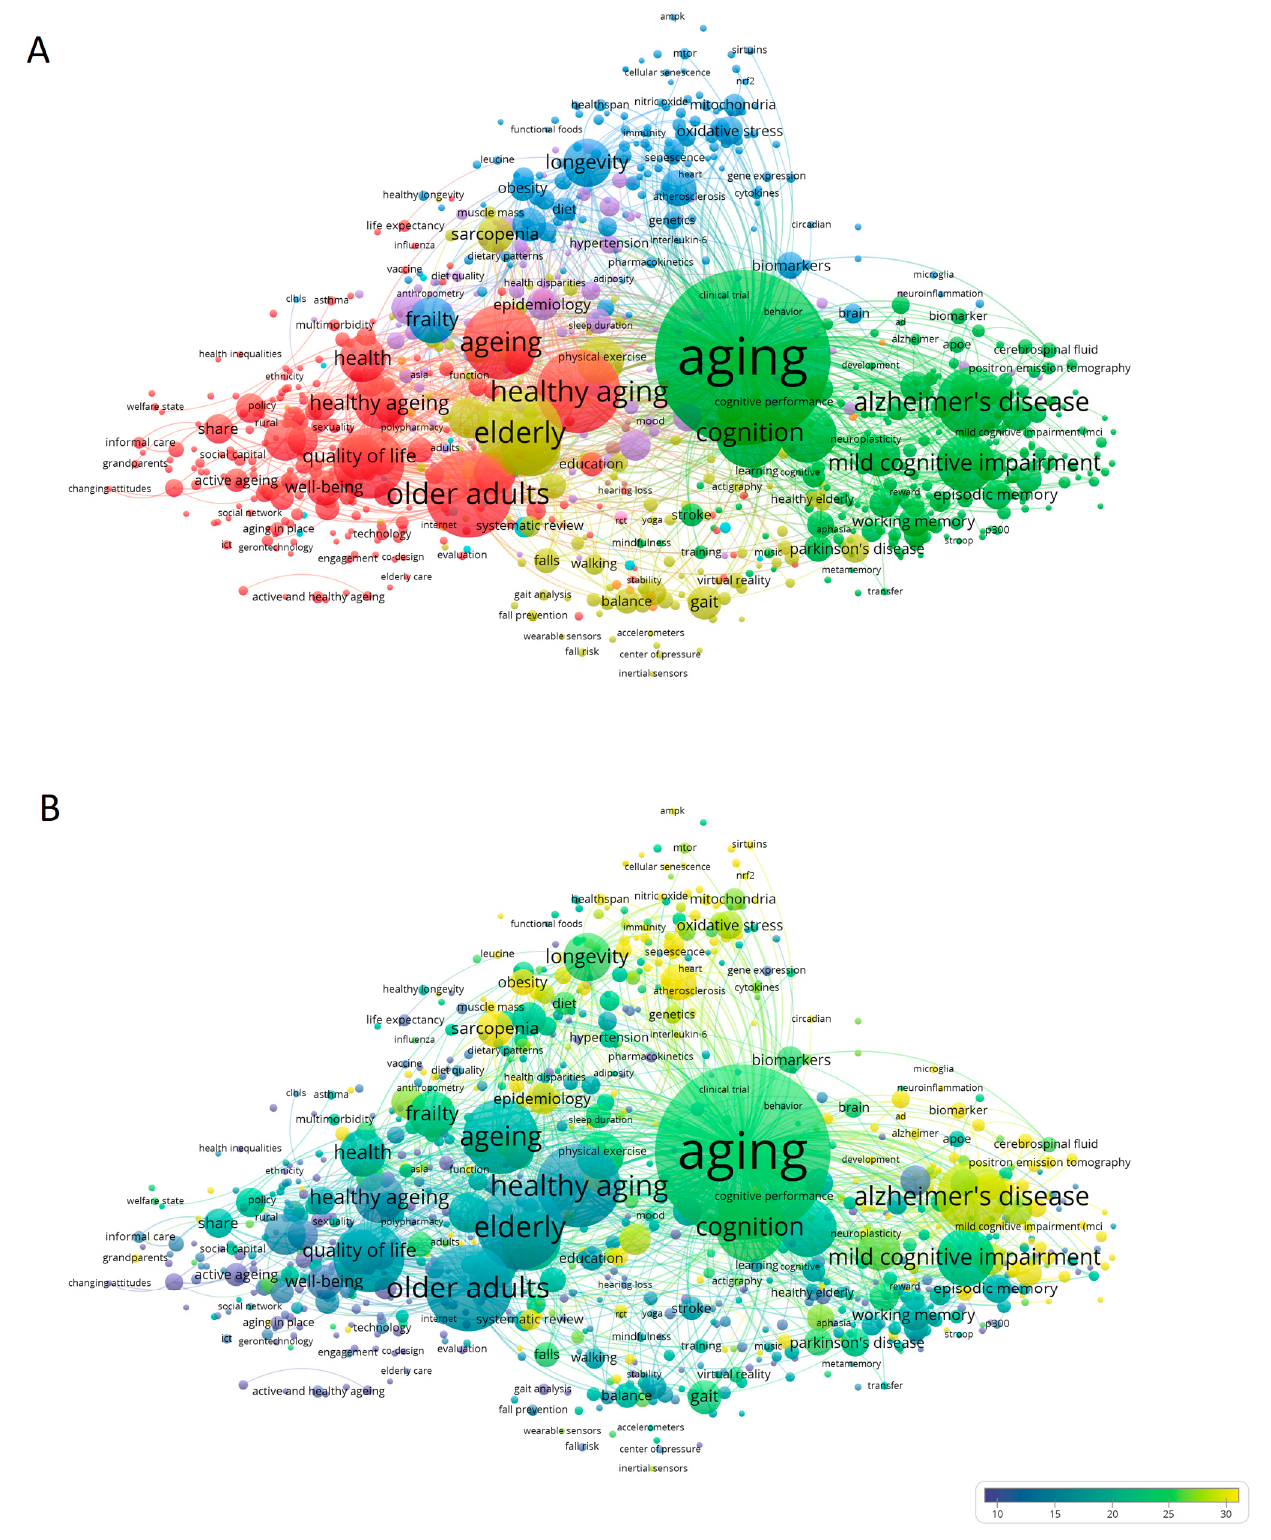
Figure 3. Co-occurrence map of the keywords defined by the authors and showing at least ten occurrences. The size of the circles is based on the number of occurrences, while the colors represent ( A ) the strength of the relationships and ( B ) the average number of citations. The map was built with the publications on the subject “healthy aging” according to Scopus (2011–2020).